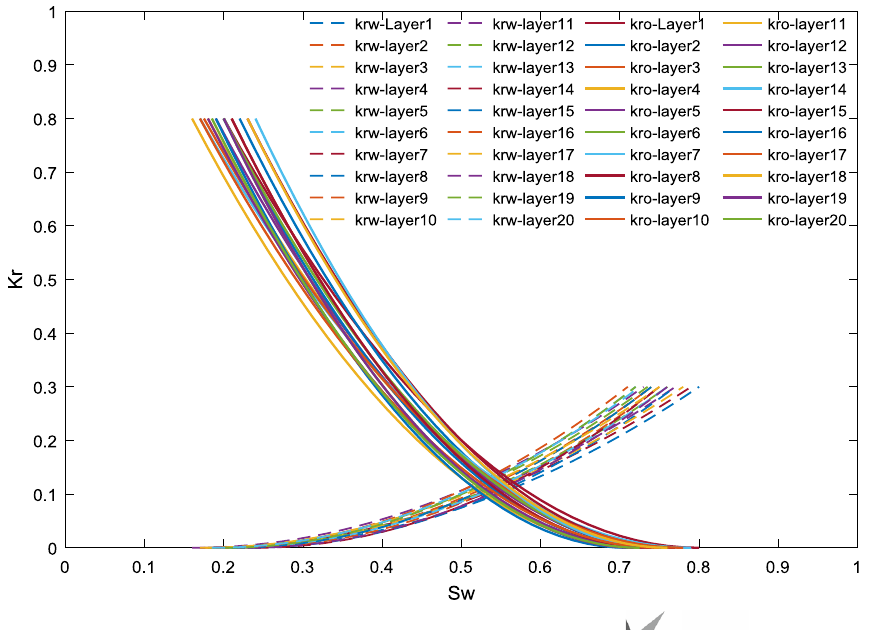
Fig. 2 Relative permeability curves for all